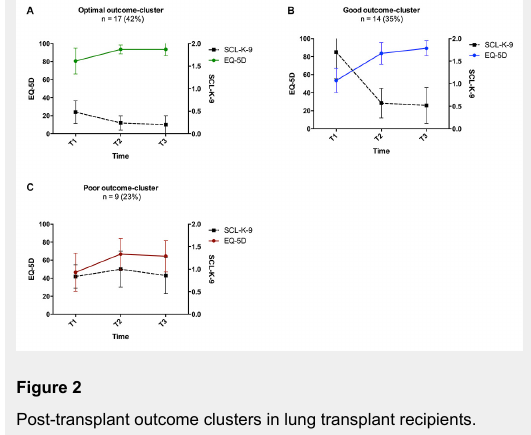
Post-transplant outcome clusters in lung transplant recipients. Plots A–C illustrate postoperative outcome clusters after lung transplant determined by cluster analysis. The left y-axis represents mean values for EQ-5D, while the right y-axis represents mean values for global SLK-9 values. Higher values indicate higher EQ-5D or poorer SCL-K-9 values, respectively. T1–T3 stand for the three different measurement time points (T1: 2 weeks; T2: 3 months; T3: 6 months post-transplant). EQ-5D = the EuroQOL five-dimension Health-Related Quality of Life questionnaire; SCL-K-9 =Symptom Checklist short version-9